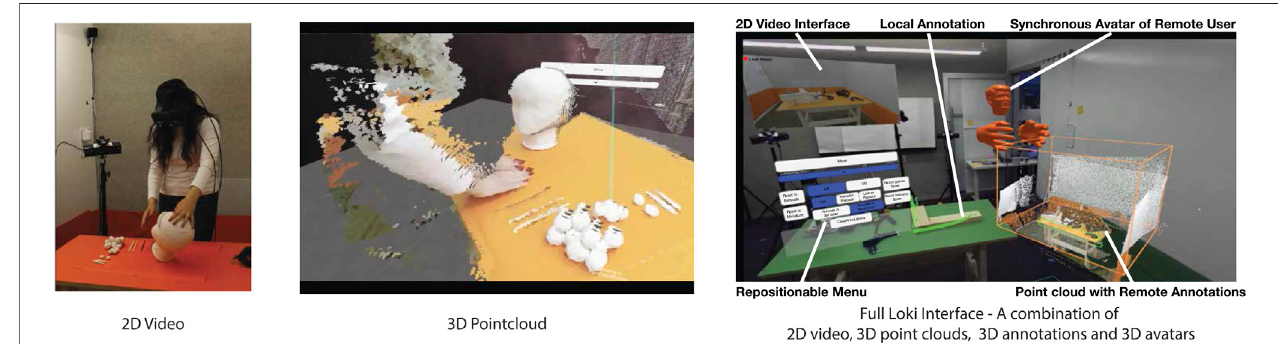
FIGURE 15 | Different visual representations of xspace in